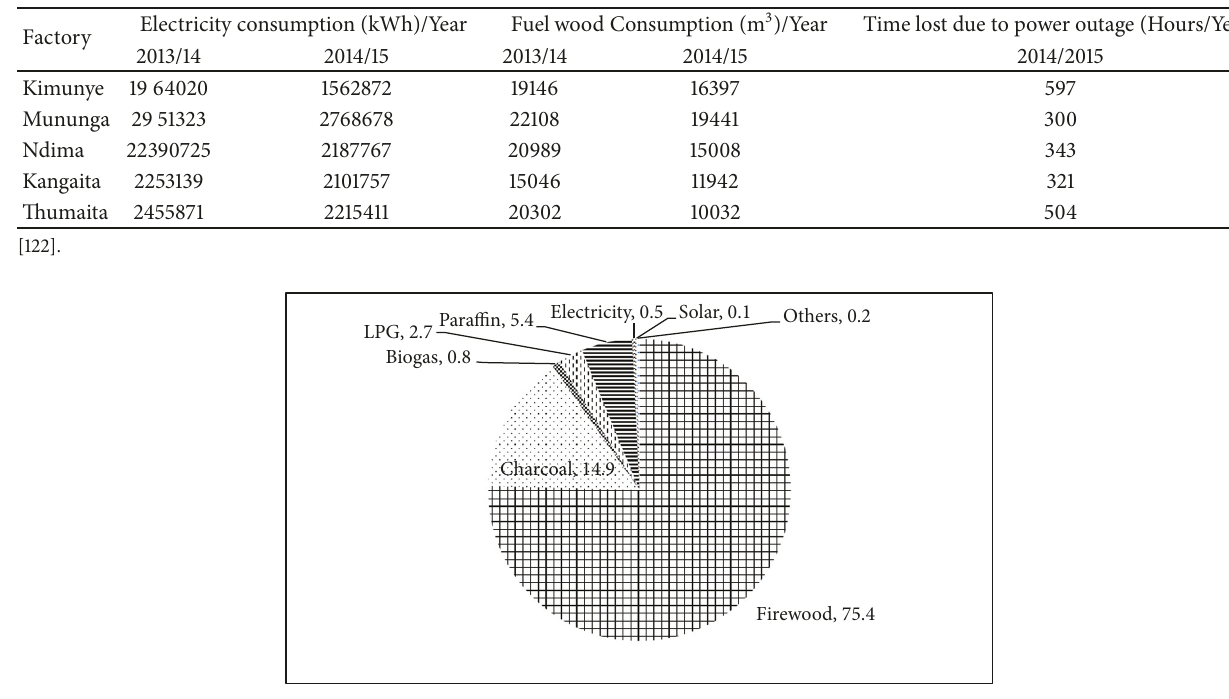
Table 2: Fuel wood and electricity consumption for tea factories in Kirinyaga and man-hours lost due to power outages.